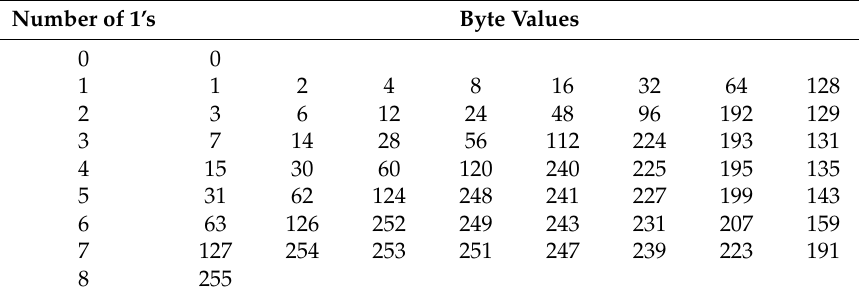
Table 3. Nine different classes of uniform Local Binary